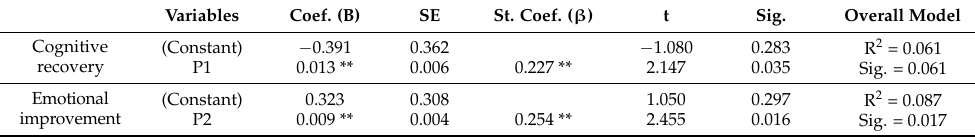
Table 8. Cognitive recovery, emotional improvement and behavior characteristics (stepwise model). Variables Coef. (B) SE St. Coef. ( β ) t Sig. Overall Model